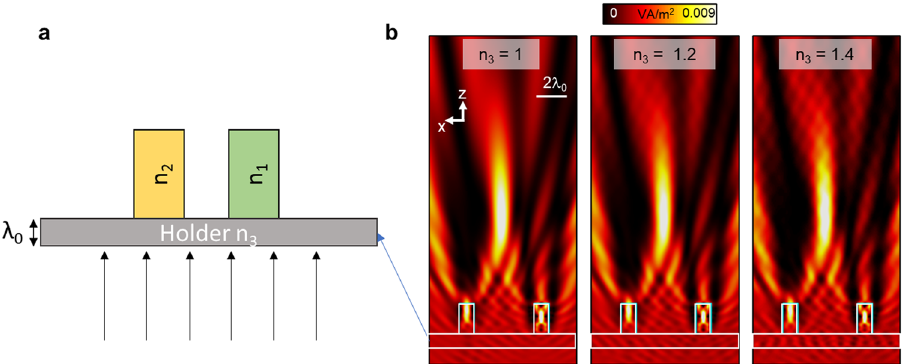
Figure 5. ( a ) Schematic representation of the proposed dual-dielectric structure on top of a dielectric holder of refractive index n 3 as a potential experimental structure. ( b ) Numerical results of the power distribution on the xz plane for the design discussed in Fig. 4d with d = 4 λ 0 when using a dielectric holder with a thickness of t = λ 0 and refractive index n 3 = 1 (left), n 3 = 1.2 (middle) and n 3 = 1.4 (right), respectively. Panel ( a ) was created using Microsoft PowerPoint version